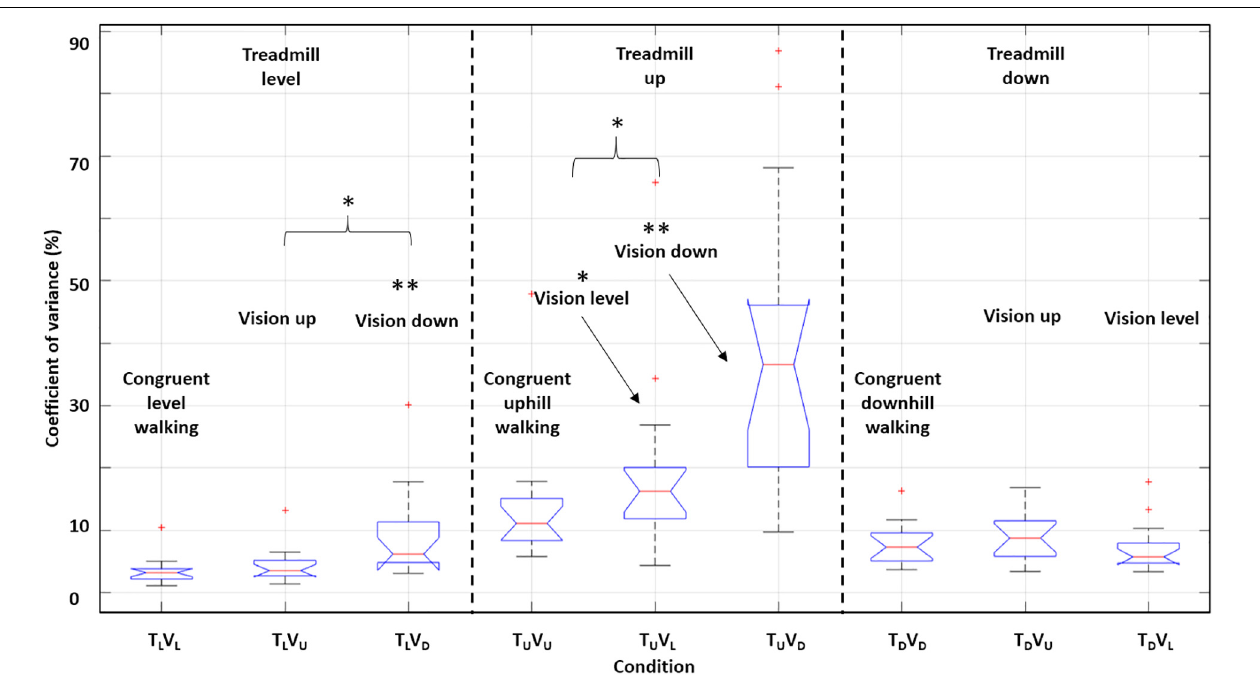
FIGURE 10 | Impact on the coefficient of variance of walking speed induced by incongruent sensory information. Boxplots depicting coefficient of variance of walking speed during the first 20 s post-transition. For each boxplot, the central red line indicates the median, and the upper and lower edges indicate interquartile range. Outliers are plotted using red ‘+’ symbols. Here we marginalized according to the treadmill inclination. Vision down led to more variable gait in conditions with treadmill level and up. There were no differences across conditions with treadmill down. For each treadmill inclination, paired t -tests (two-tailed) were run between each incongruent condition and the congruent condition, and between the two incongruent conditions. ∗ P < 0.05, ∗∗ P < 0.01. Asterisks that appear without a brace indicate comparison to the corresponding congruent condition.